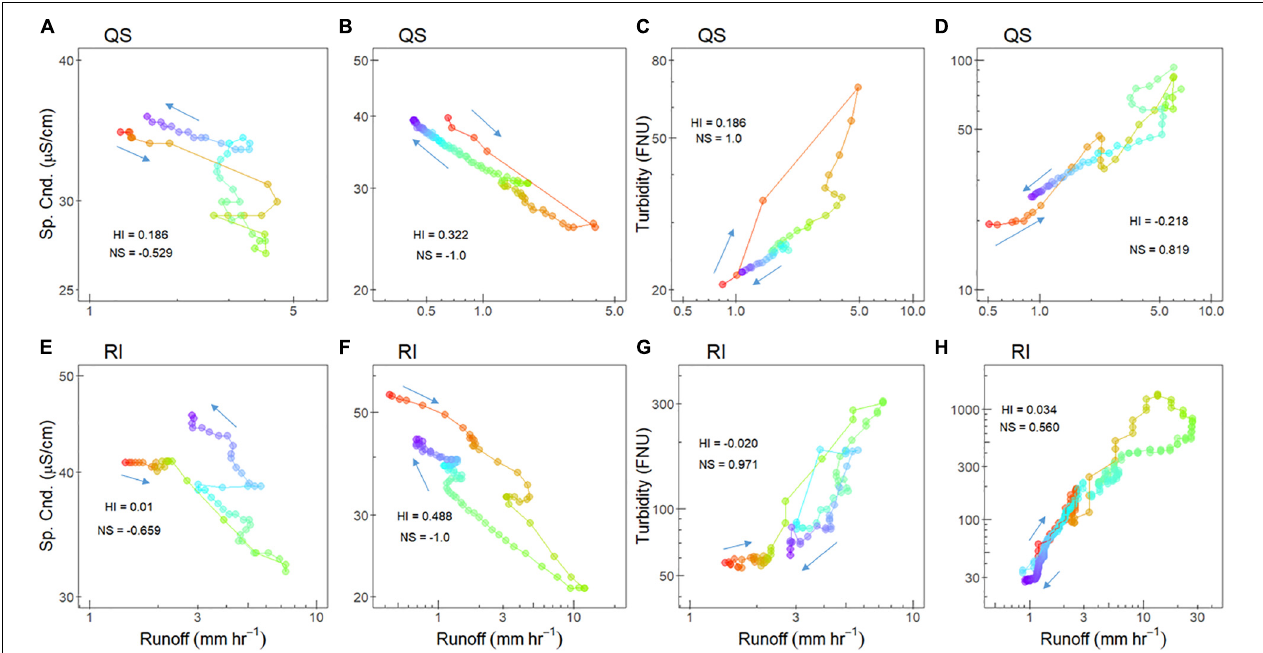
FIGURE 2 | Typical specific conductance (Sp. Cnd.) and turbidity responses to increased streamflow during individual storm events. Red/orange colors represent the beginning of the storm and blue/purple colors represent the end of the storm. Arrows also provide beginning and ending points of each event. The top row of (A–D) shows the response of specific conductance and turbidity at Quebrada Sonadora (QS) and the bottom row of (E–H) shows the response of specific conductance and turbidity at Rio Icacos (RI). Hysteresis index (HI), and normalized slope (NS) values are presented for each storm. Specific conductance generally dilutes in response to increased flow whereas turbidity exhibits flushing behavior. Note that both axes are log-scaled.